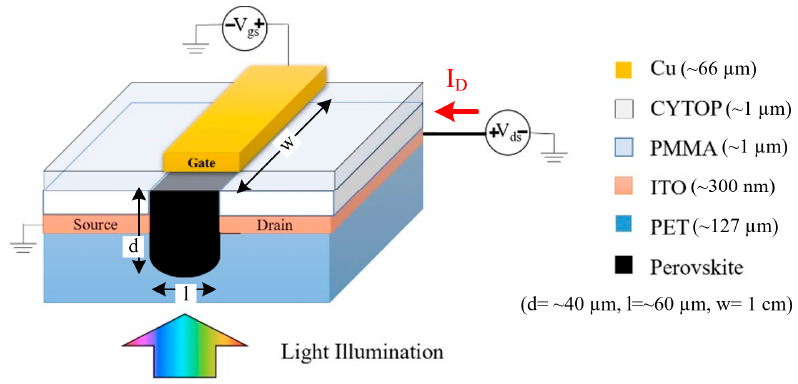
Figure 1. Schematic of the fabricated MAPbI 3 phototransistor.